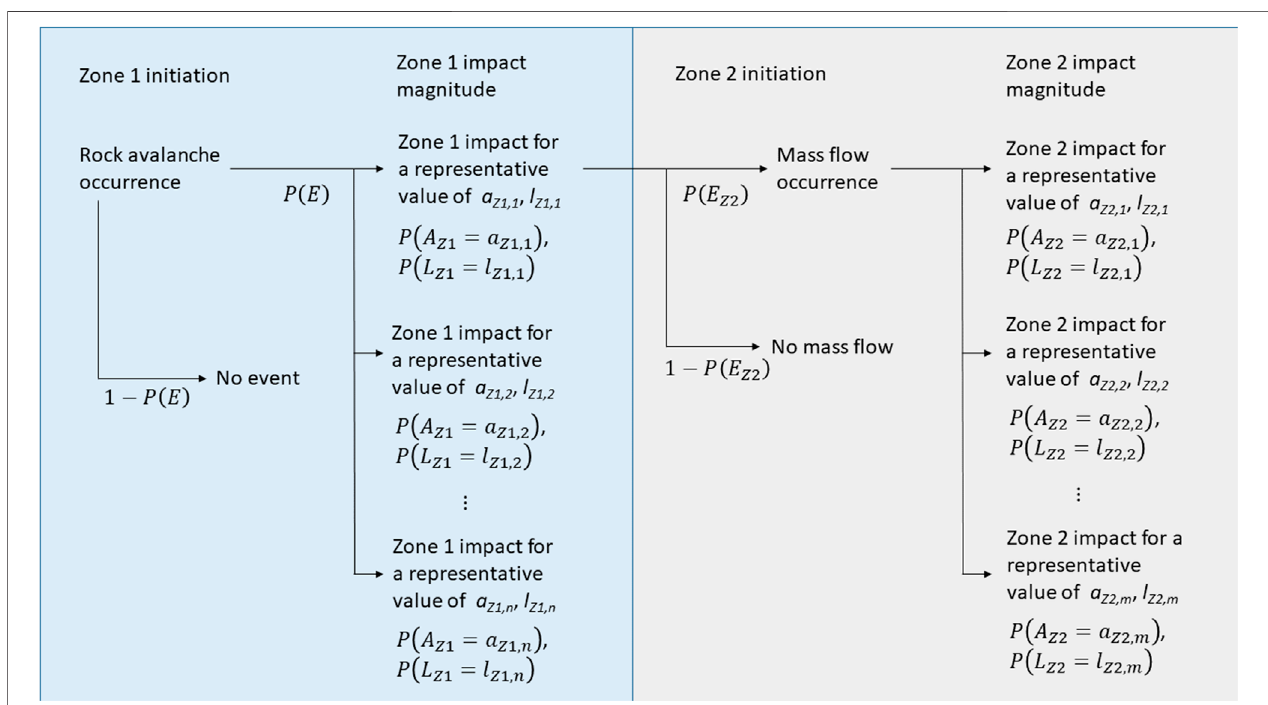
a Indicates attributes or descriptors that are only used for Zone 1 Impacts.